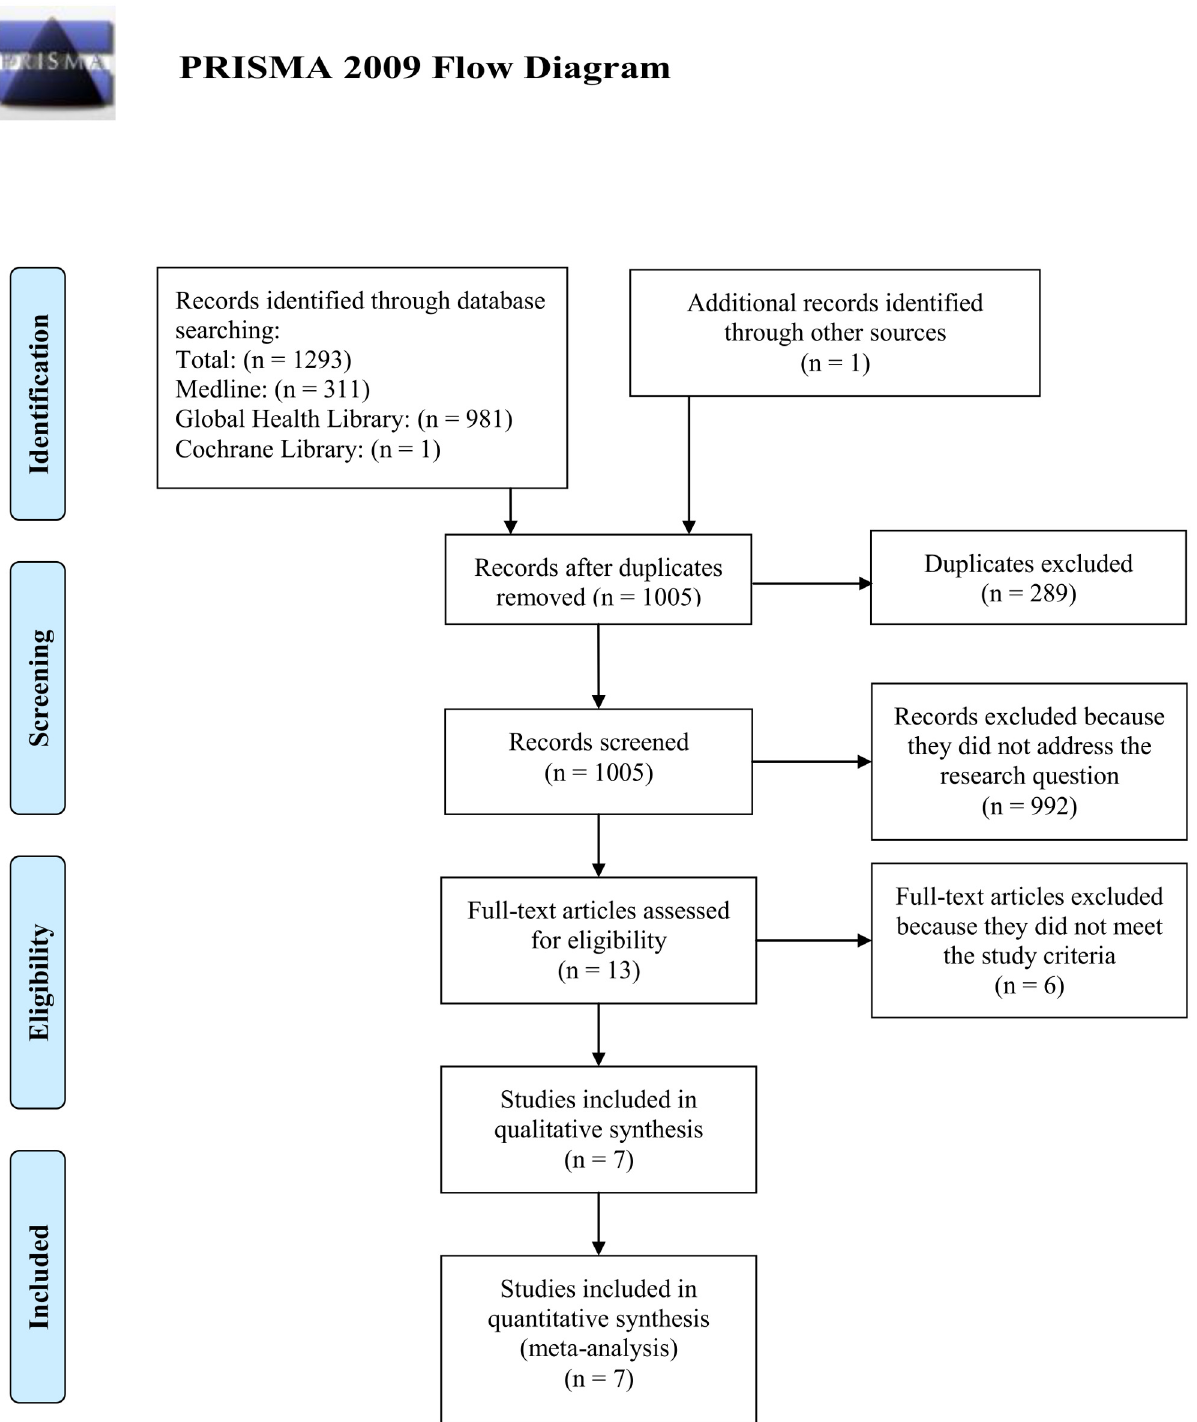
Fig 1. Search strategy for a systematic review and meta-analysis to determine fetal, neonatal, and maternal mortality among pregnant women with cholera.